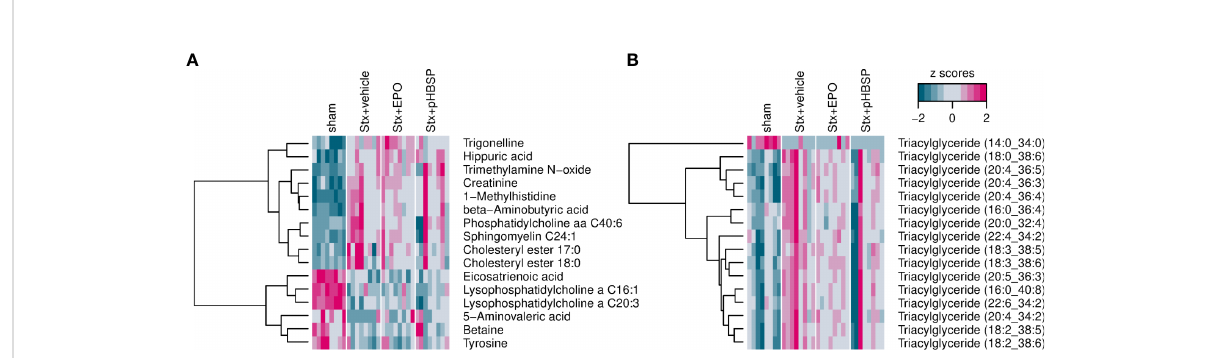
FIGURE 8 Effect of EPO and pHBSP treatment on plasma metabolome in mice with HUS. Metabolites in plasma of sham mice and Stx-challenged mice were assessed on day 7 of HUS experiment. Statistic modelling was performed to test the hypothesis that their abundance either increases or decreases in the following order: sham – Stx+pHBSP – Stx+EPO – Stx+vehicle (A) Small metabolites in murine plasma showing a signi fi cant trend for the four groups under investigation. (B) Triacylglyceroles in murine plasma showing a signi fi cant trend for the four groups under investigation. Data are shown as heatmaps depicting z-scores for all samples. The analytes were hierarchically clustered using Ward ’ s minimum variance method (45) and an euclidian distance between z scores. Dendograms provide information about distances between